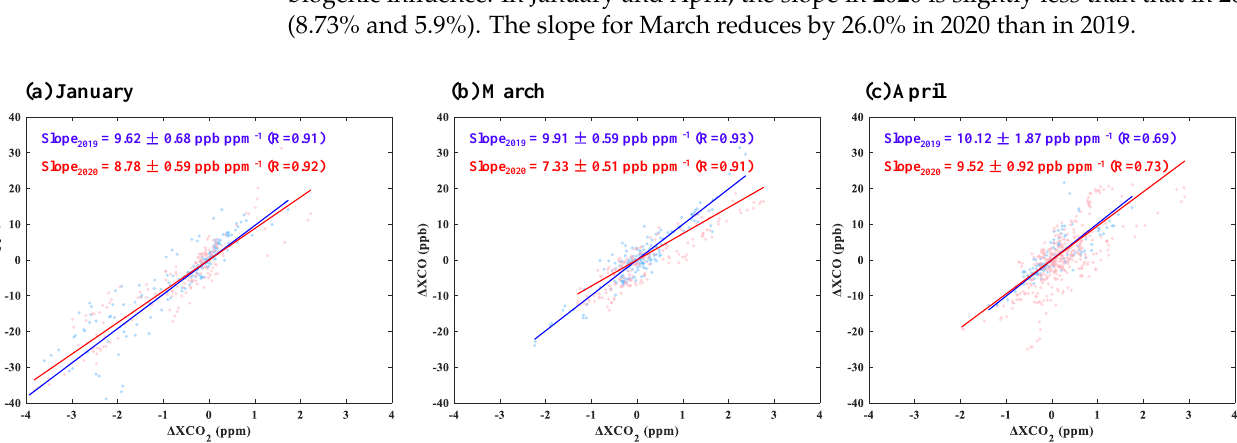
biogenic influence. In January and April, the slope in 2020 is slightly less than that in 2020